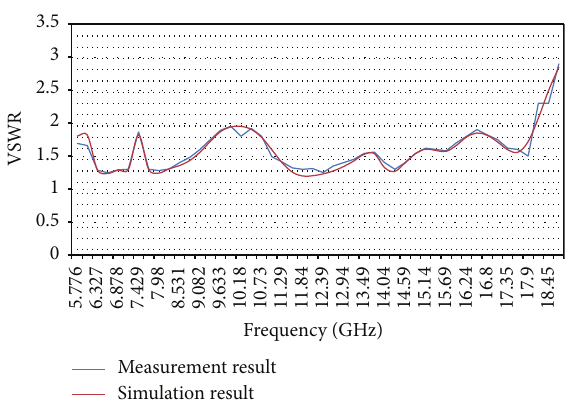
Figure 11: VSWR measurement of fabricated